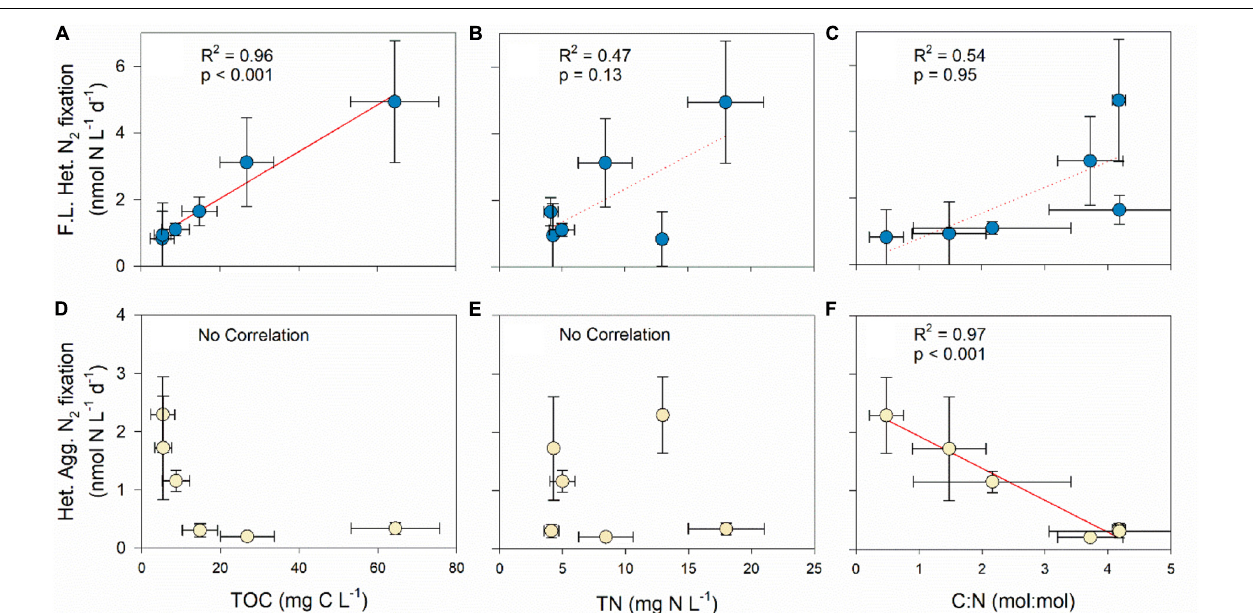
FIGURE 3 | Pearson correlation test between free-living (F.L.) and aggregate-associated (Agg.) heterotrophic (het.) N 2 fixation to TOC (A,D) , TN (B,E) , and C : N (C,F) . The statistical results are shown in the different panels ( n = 6). Solid trend line indicates that the correlation between the different variables was significant, while dash line shows the trend